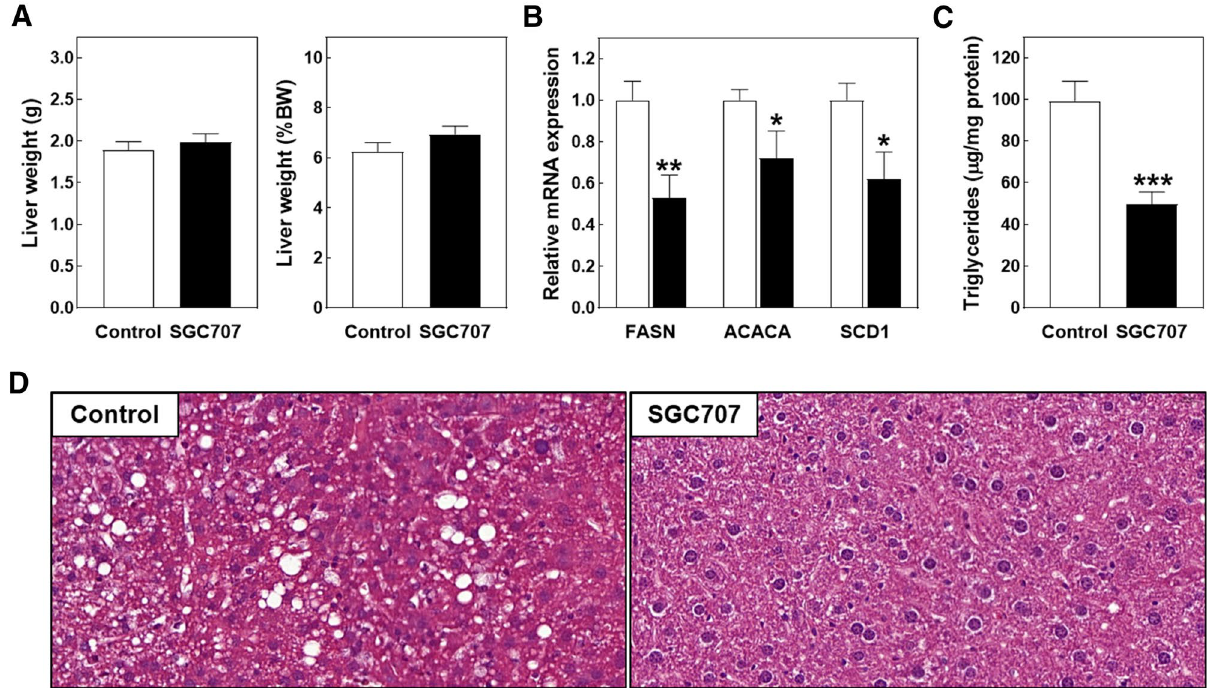
Figure 1. ( A ) Absolute and body weight (BW) corrected liver weights, and liver relative mRNA expression levels of lipogenic genes ( B ) and triglyceride levels ( C ) in livers of Western-type diet-fed male LDL receptor knockout mice treated with the PRMT3 inhibitor SGC707 or the solvent control. Values in the graphs represent the means + SEM of 11 mice per group. * P < 0.05, ** P < 0.01, *** P < 0.001 versus control. ( D ) Representative images of hematoxylin/eosin-stained liver sections showing marked steatosis, i.e. lipid droplets, only in tissue of the control group (magnification: